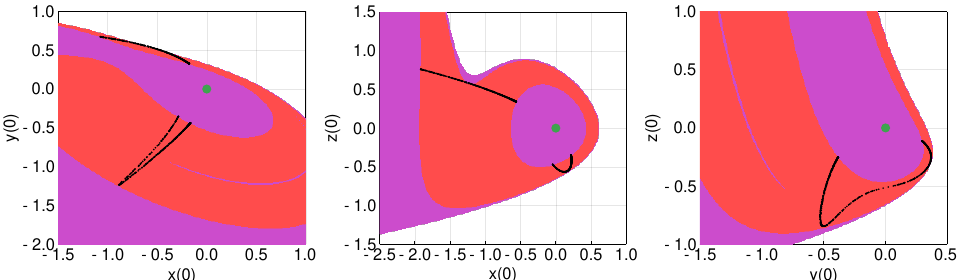
Figure 9. Cross sections of the basins of attraction of the two coexisting attractors in the coordinate planes: z ( 0 ) = 0 ( left ); y ( 0 ) = 0 ( center ); x ( 0 ) = 0 ( right ). Initial conditions in the white regions lead to unbounded orbits, those in the red regions lead to the hidden chaotic attractor, and those in the purple regions lead to the stable equilibrium located at the